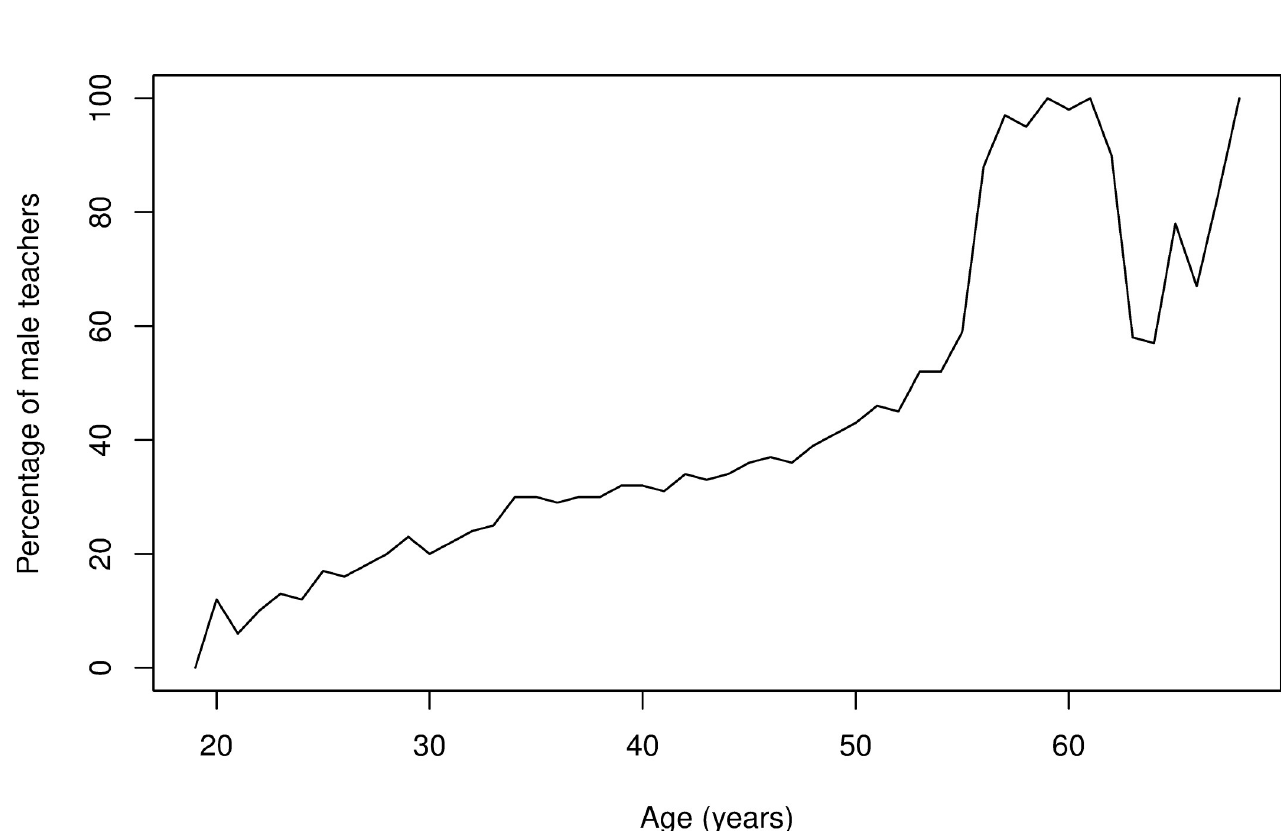
Fig 2. Percentage of male teachers by age.